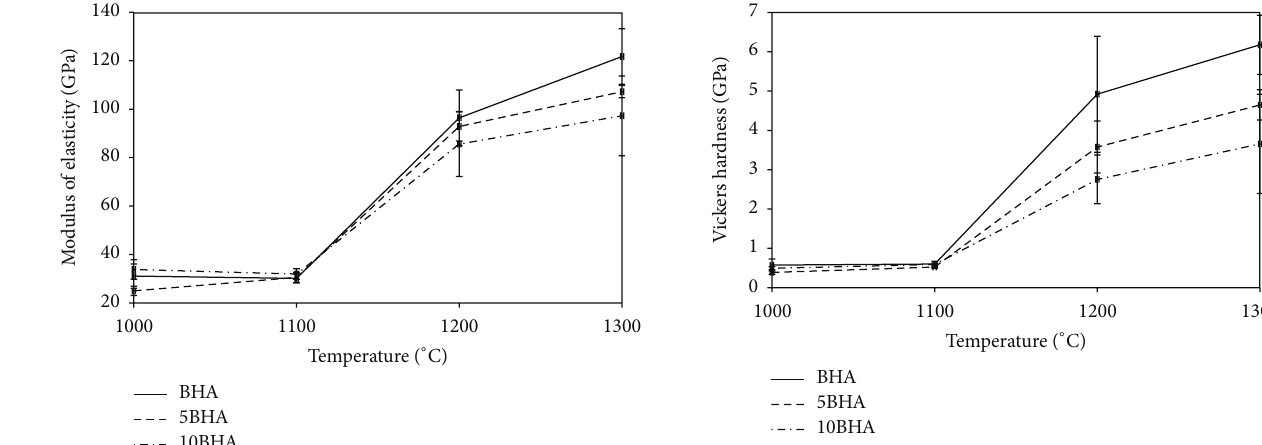
Figure 9: Variation of modulus of elasticity of BHA, 5BHA, and 10BHA composites at different sintering temperature.